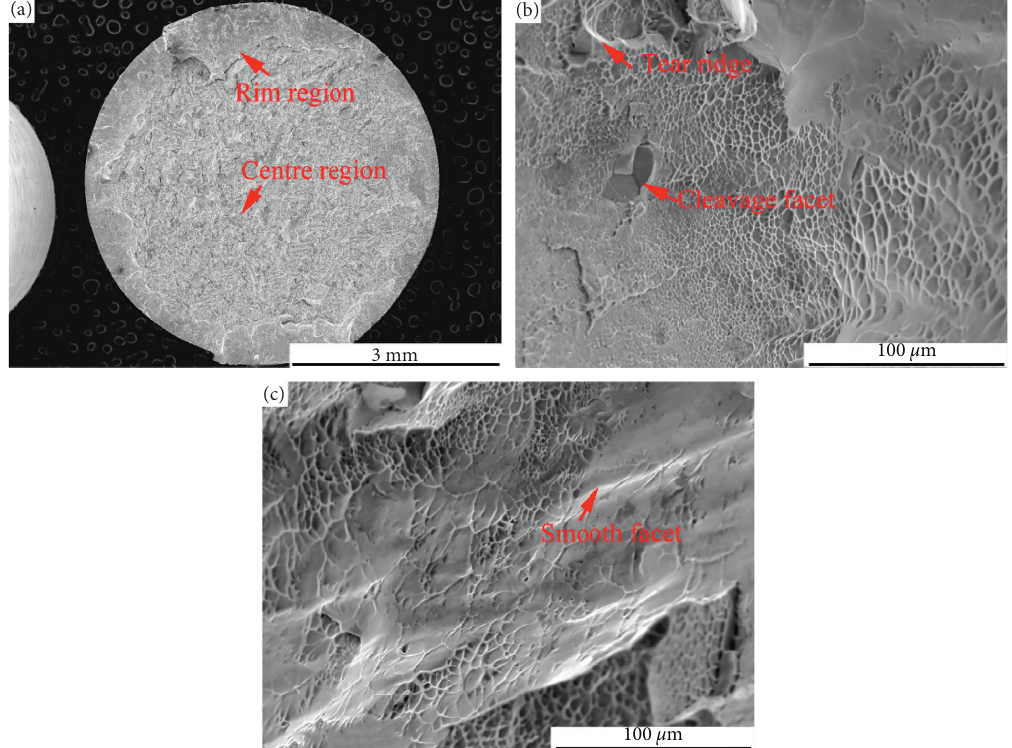
Figure 15: (a) Fracture surface of specimens after RHTand ageing; (b) and (c) rim regions of specimens after rapidly heating to 875 ° C and 950 o C followed by